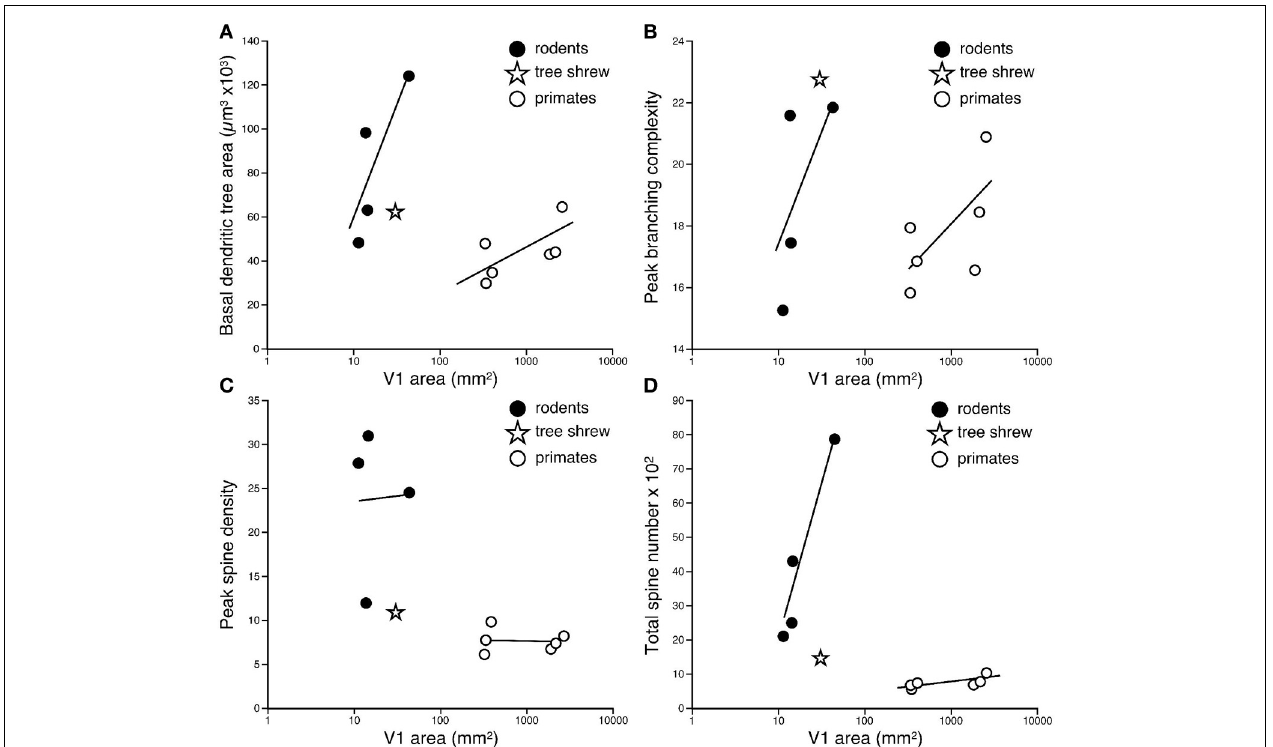
FIGURE 5 | Logarhythmic plots of the basal dendritic tree areas (A), peak branching complexity (B), peak spine density (C), and total spine number (D) of the “average” pyramidal cell against the size of the primary visual area (V1) in the cane rat, bushveld gerbil, four-striped mouse, agouti, tree shrew, galago, marmoset monkey, owl monkey, guenon (vervet monkey), macaque monkey, and baboon (see Table 1 for raw data and sources of